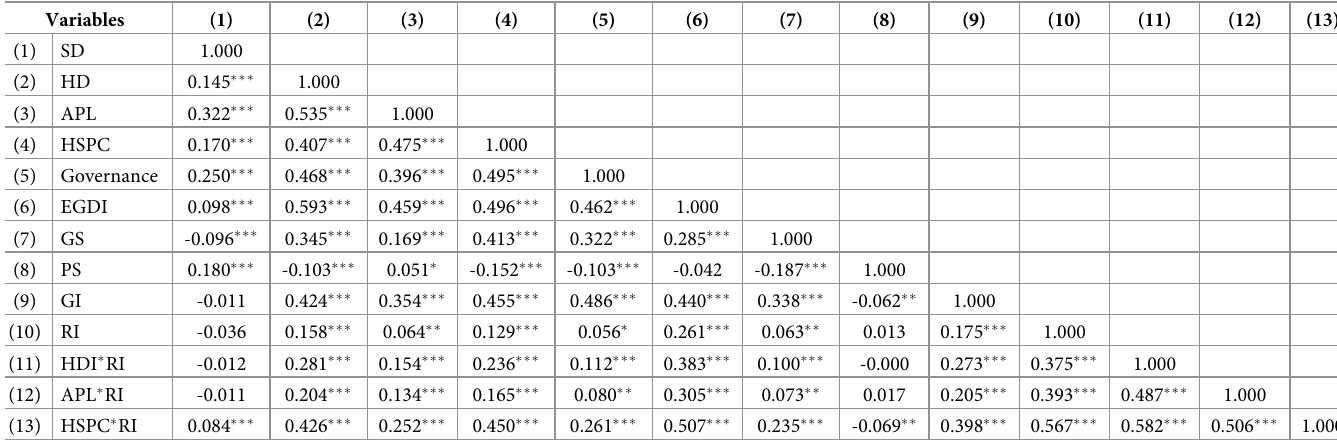
Table 2. Pairwise